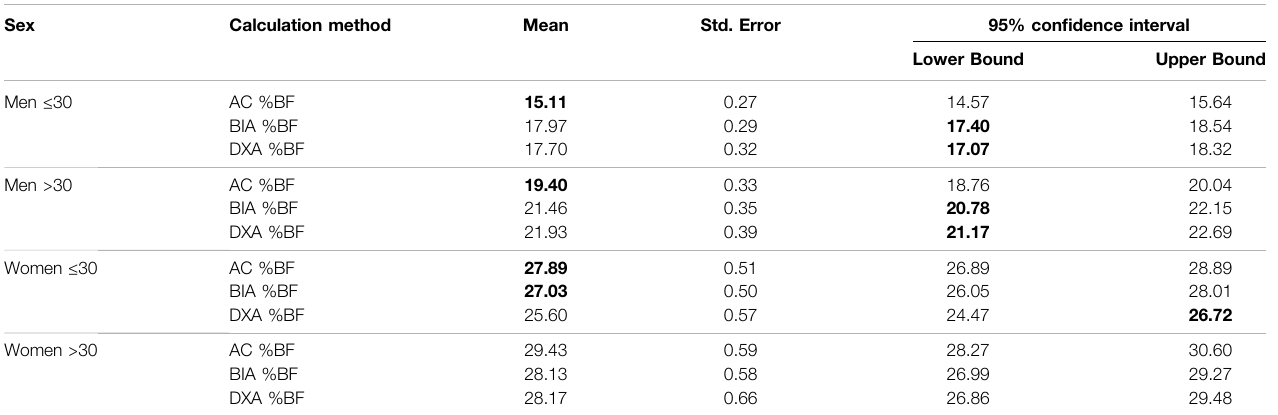
Bold cells indicate mean values outside DXA %BF, lower and upper bound reference values.